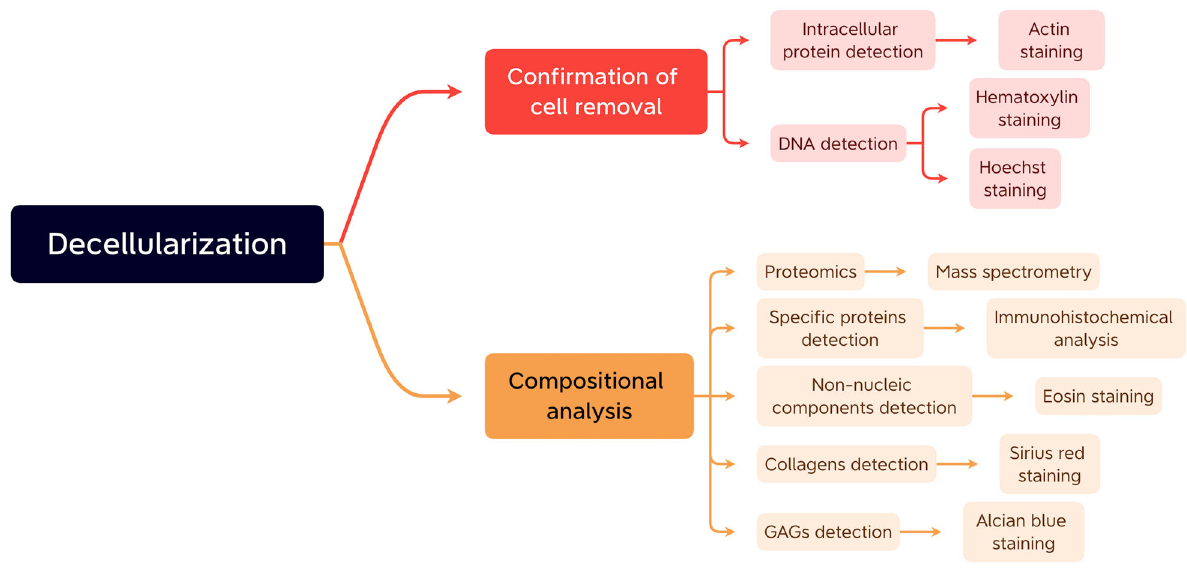
Figure 5. The usual methods of confirmation of cell removal and compositional